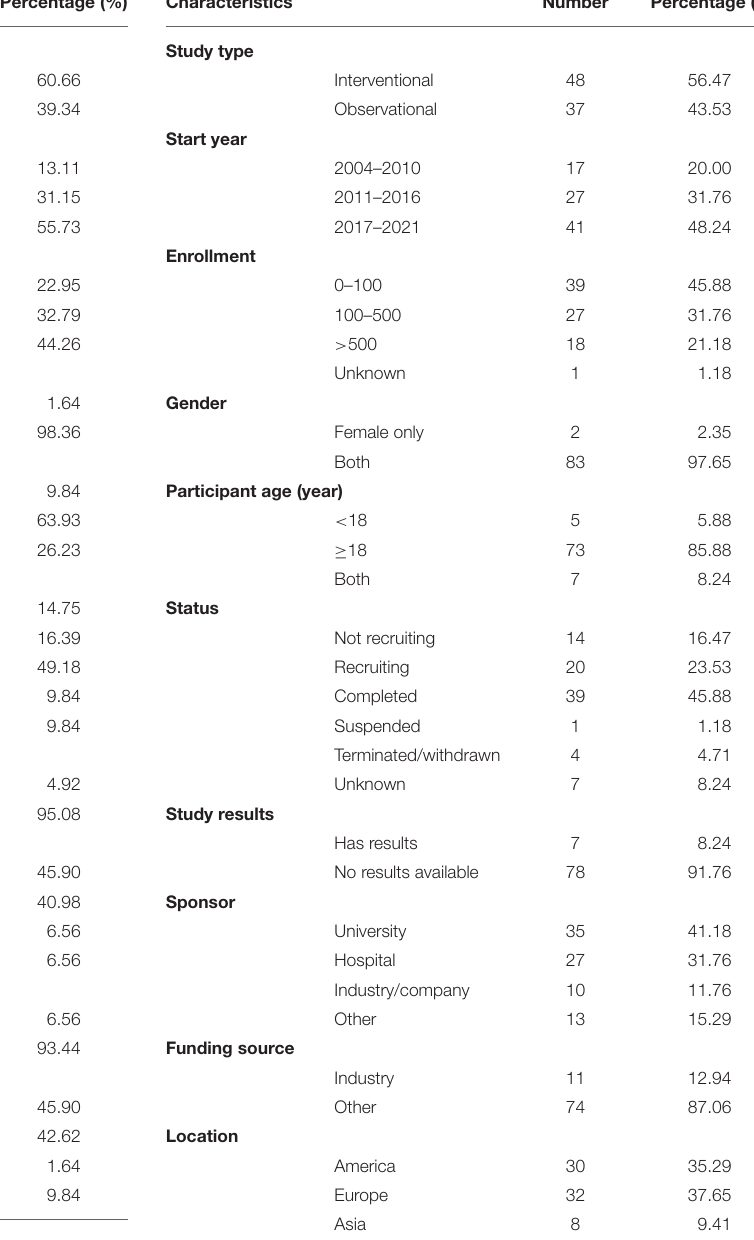
TABLE 4 | The characteristics of the 61 trials in ED registered on ClinicalTrial.gov. Characteristics